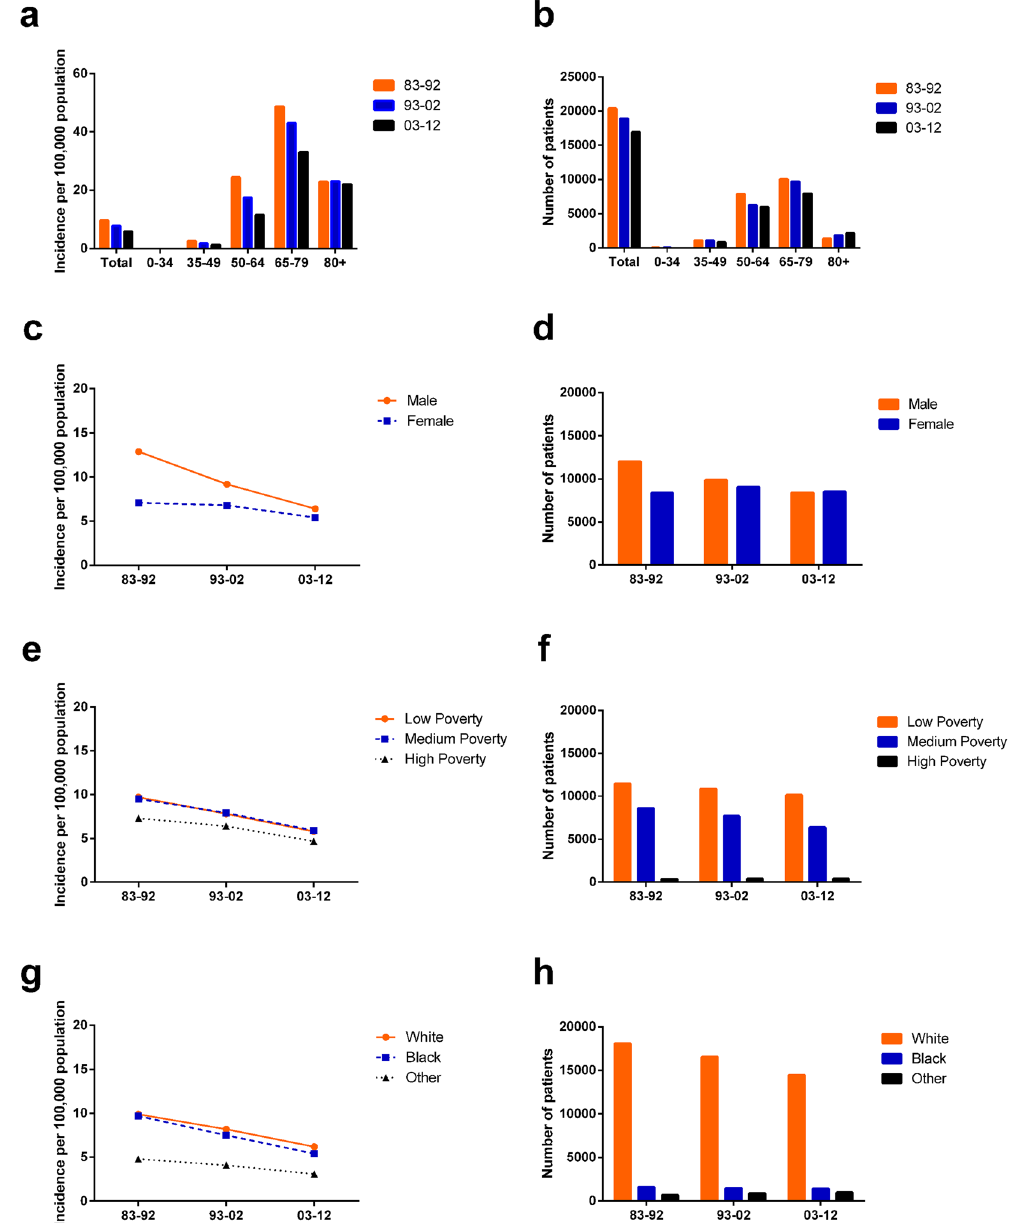
35–49, 50–64, 65–79, and 80 + years) and calendar period. Incidence and number of SCLC cases are grouped